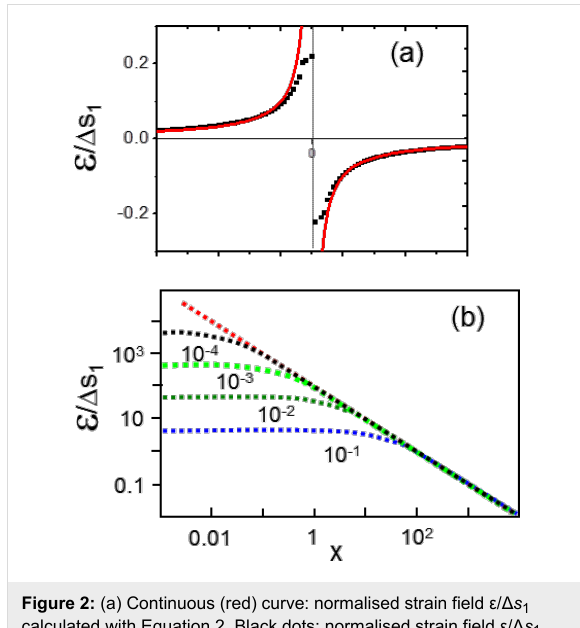
Figure 2: (a) Continuous (red) curve: normalised strain field ε / Δ s 1 calculated with Equation 2, Black dots: normalised strain field ε / Δ s 1 calculated from Equation 4 with Δ s 1 / S 11 = 0.4 (b) ln–ln diagram of the normalised strain field ε / Δ s 1 calculated from Equation 4 for hS 11 varying from 10 − 1 to 10 − 4 (arbitrary units). The common asymptote is the classical result calculated from Equation 2.